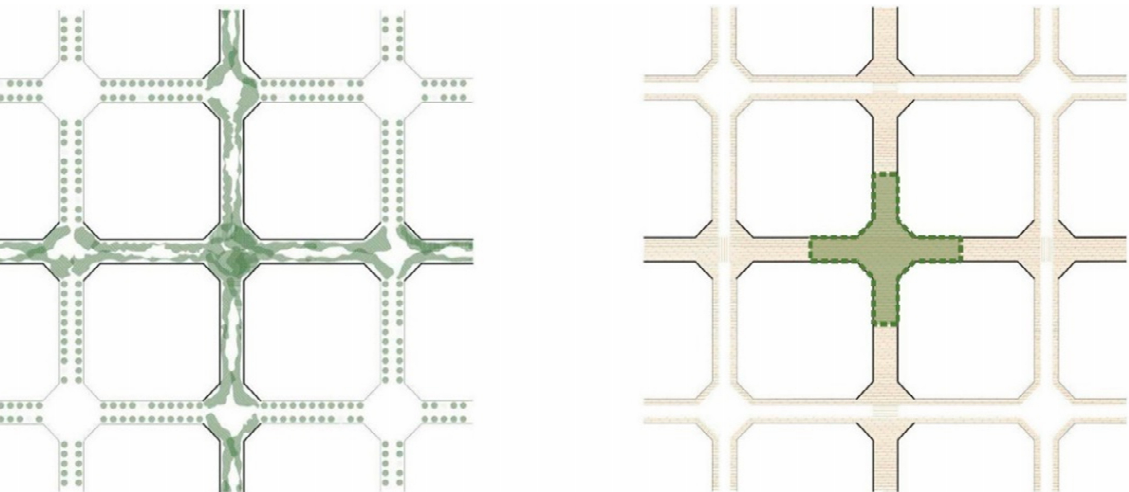
Figure 3. ( Left ) Vegetation scheme in the green axes within the usual set of tree vegetation in Barcelona’s urban expansion area. ( Right ) A 0.5-hectare area at the intersection between green axes Source: the authors, based on Ajuntament de Barcelona [56].